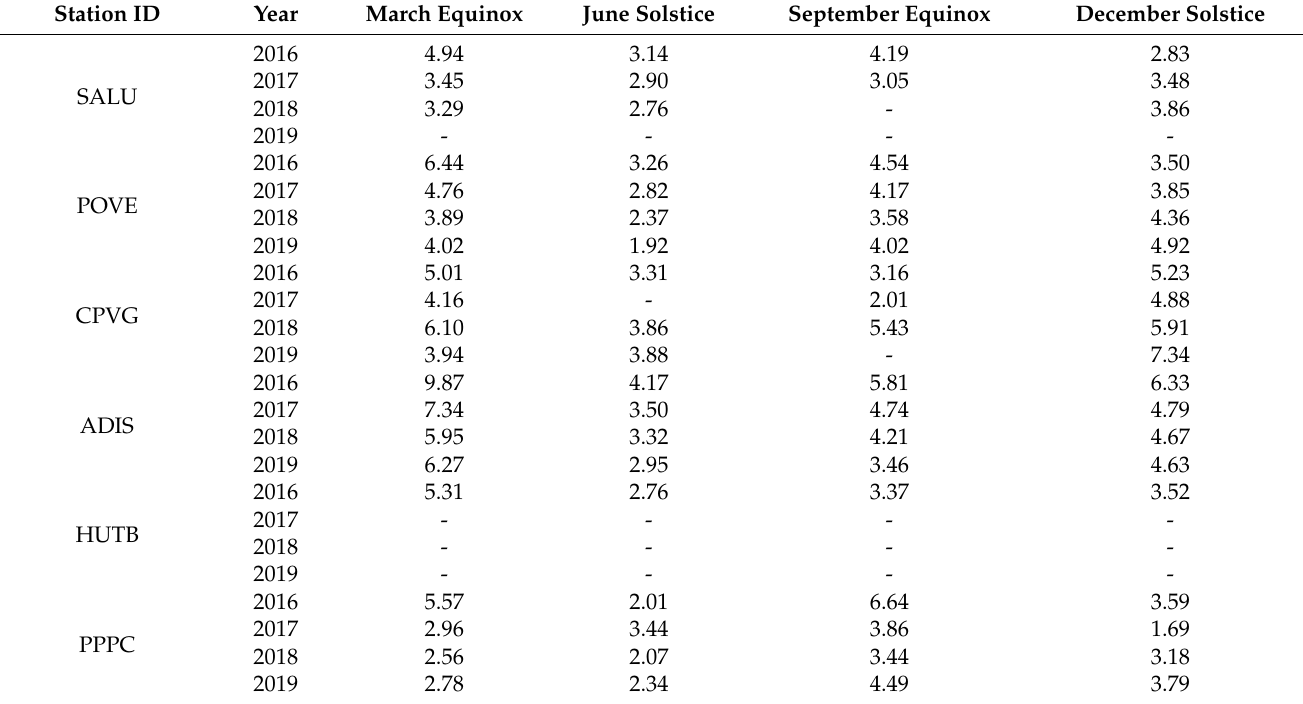
Table 3. RMSE between GPS-TEC and